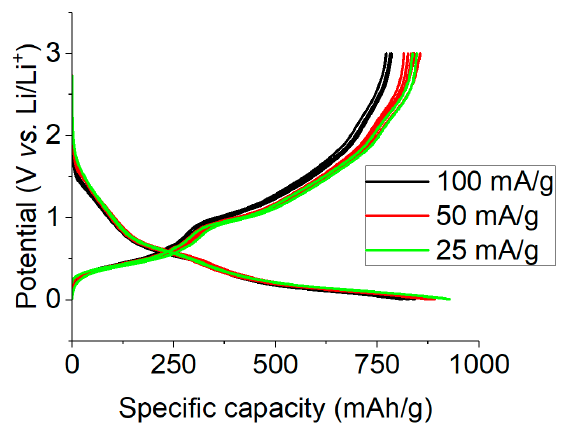
Figure 4. Charge and discharge curves for sodium insertion/extraction into/from CoGe 2 P 0.1 at various current densities.